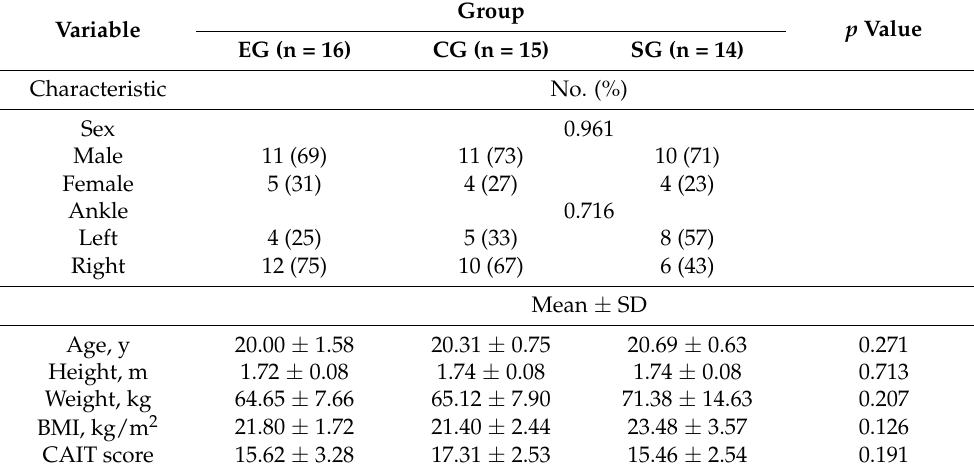
Table 2. Descriptive data of subjects in each group. Data are reported as mean ± SD.